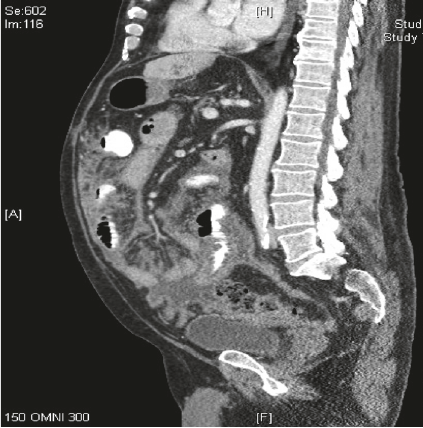
Figure 1: Diffuse nonspecific bowel edema.